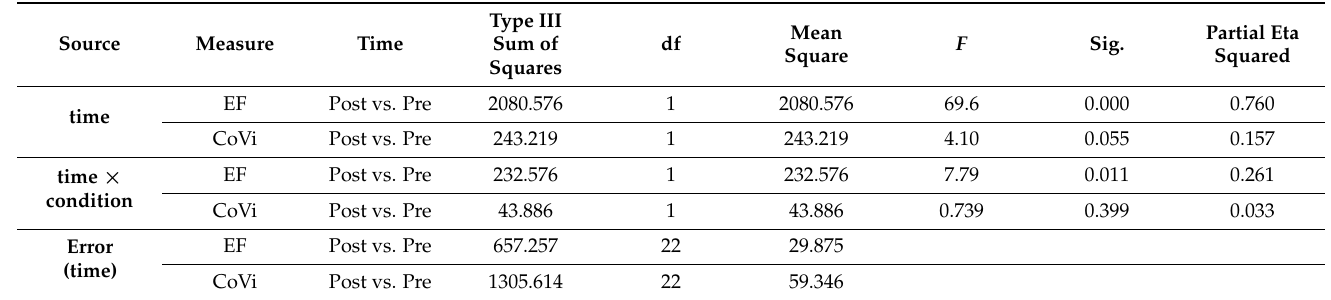
Table 2. Tests of within-groups contrasts measured over time.